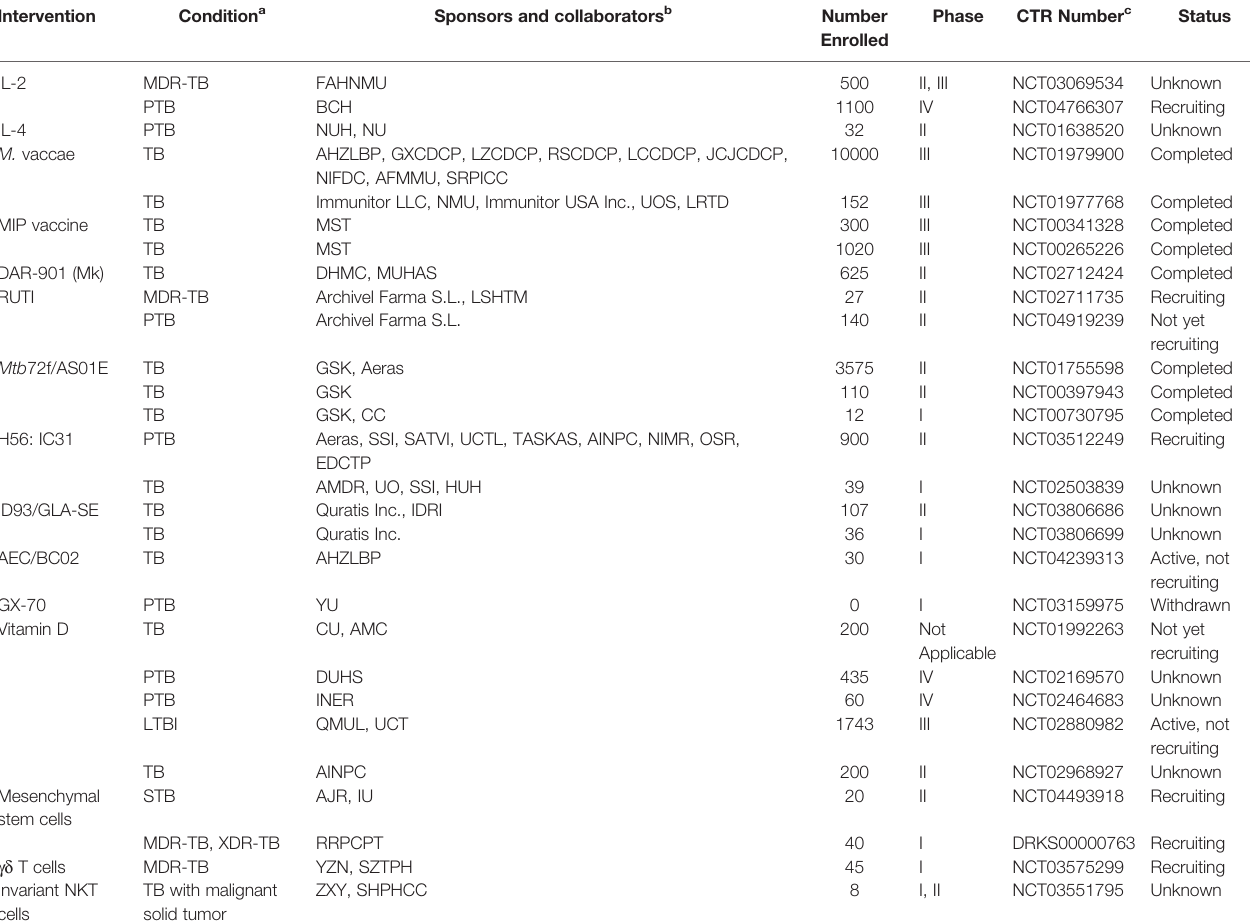
TABLE 2 | The development of clinical trials in immunoactive substances, vaccines, chemical agents, and cellular